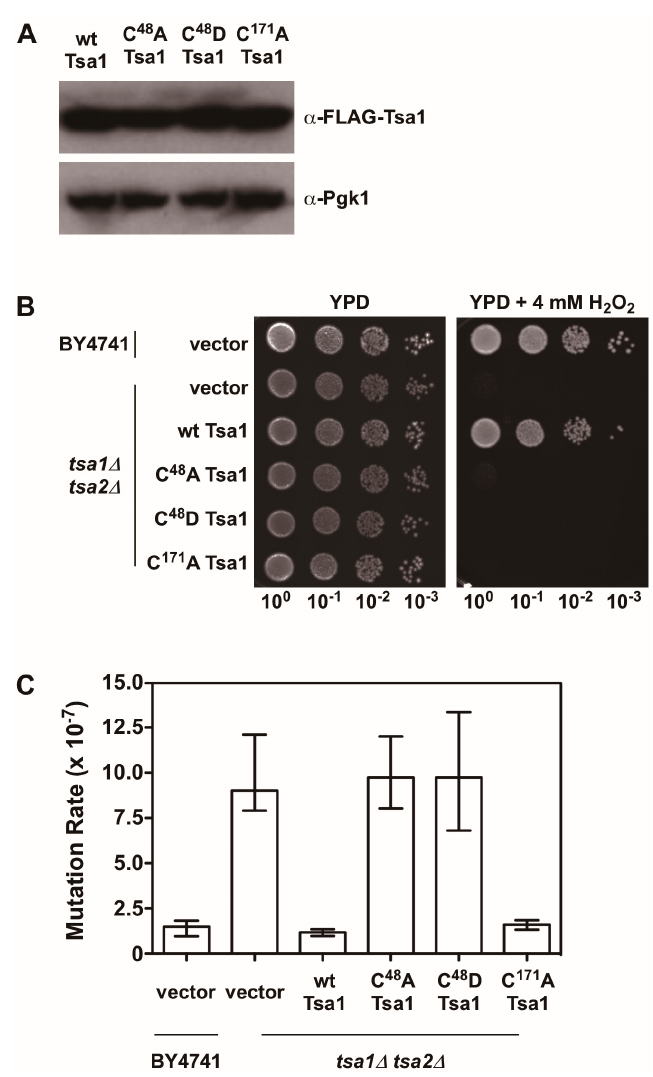
Figure 4. The peroxidatic cysteine in Tsa1 is required to protect against H 2 O 2 and lower mutation rates. ( A ) Western blot analysis of FLAG-tagged Tsa1 variants. Pgk1 levels were monitored as a loading control. ( B ) Stationary phase cultures of wild-type (BY4741) cells transformed with vector, tsa1 ∆ tsa2 ∆ cells transformed with vector, or tsa1 ∆ tsa2 ∆ cells expressing FLAG-tagged Tsa1 variants were diluted serially, plated on non-selective growth medium (YPD) or YPD containing 4 mM H 2 O 2 , and grown for 48 h at 30 ◦ C. Results are representative of three independent experiments. ( C ) Mutation rates in cells expressing Tsa1 variants were determined by monitoring fluctuation of the CAN1 gene, as assessed by counting canavanine-resistant colonies for nine independent isolates of each strain in duplicate. The graph depicts the median mutation rate ± the 95% confidence limit for each strain. Detailed methods are available in Supplementary Materials.